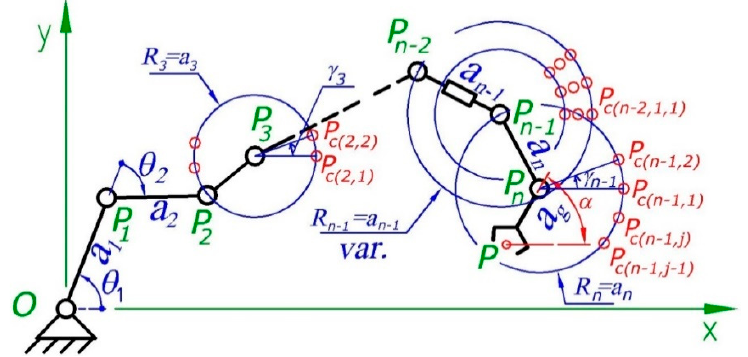
Figure 6. Determining solutions for the inverse kinematics from the gripper to the